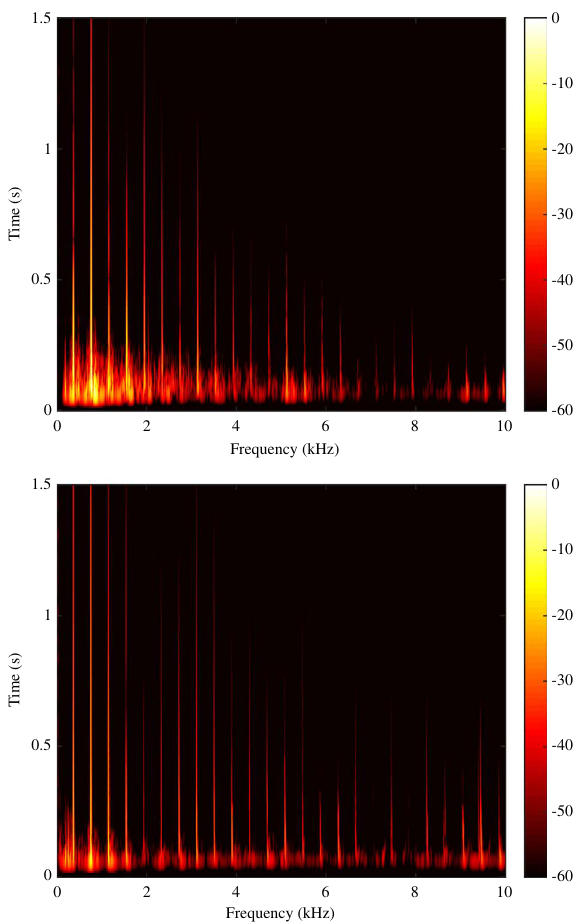
Figure 2. Spectrograms of plucked notes G4 (392 Hz) on the top string of (a) the banjo; (b) the guitar. The colour scale corresponds to identical levels (in dB) in both